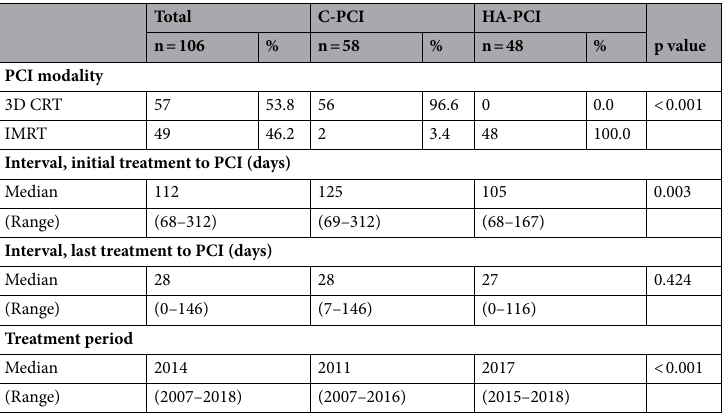
Table 1. Patient and treatment characteristics. C-PCI conventional prophylactic cranial irradiation, HA-PCI hippocampus-avoidance PCI, ECOG PS Eastern Cooperative Oncology Group Performance Status, AJCC American Joint Committee on Cancer, RT radiotherapy, CRT chemoradiotherapy, EP etoposide/cisplatin, EQD2 Equivalent dose in 2 Gy fractions, α/β = 10, 3D-CRT 3-dimensional conformal radiotherapy, IMRT intensity-modulated radiotherapy, CR complete response, PR partial response, SD stable disease.